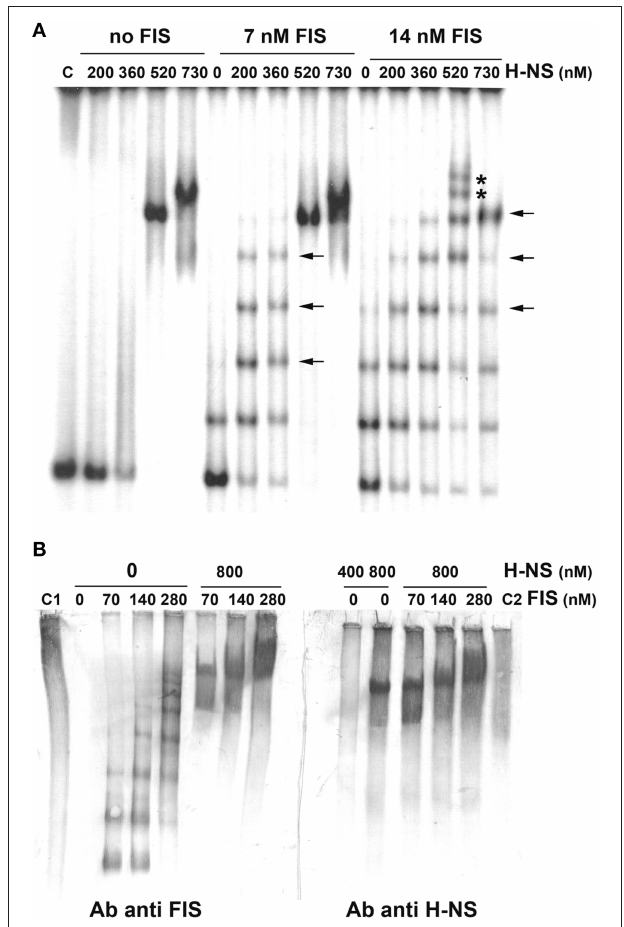
FIGURE 2 | Band shift of a DNA fragment containing the cspA promoter by FIS and H-NS. (A) The 310 bp DNA fragment, containing the cspA promoter region including the entire 5 ′ -UTR, labeled with 32 P, was used in electrophoretic mobility shift assay (EMSA) with the indicated amounts of H-NS and/or FIS. DNA-protein complexes formed preferentially or exclusively in the presence of both FIS and H-NS are indicated by arrows or asterisks, respectively. (B) EMSA experiments, carried out in duplicate, were subjected to Western Blot. After electrophoresis and elettroblotting, membranes were alternatively developed with antibodies anti-FIS or anti-H-NS as indicated. Lanes C1 and C2 represent the free FIS and H-NS proteins without DNA, respectively. Proteins concentration is given assuming dimeric structure. For further details see Materials and